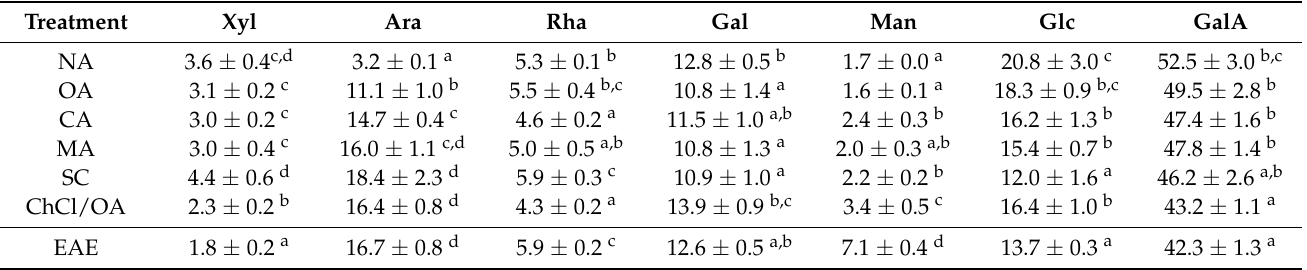
Different letters within the same column indicate significant differences between sample groups (extract- ing